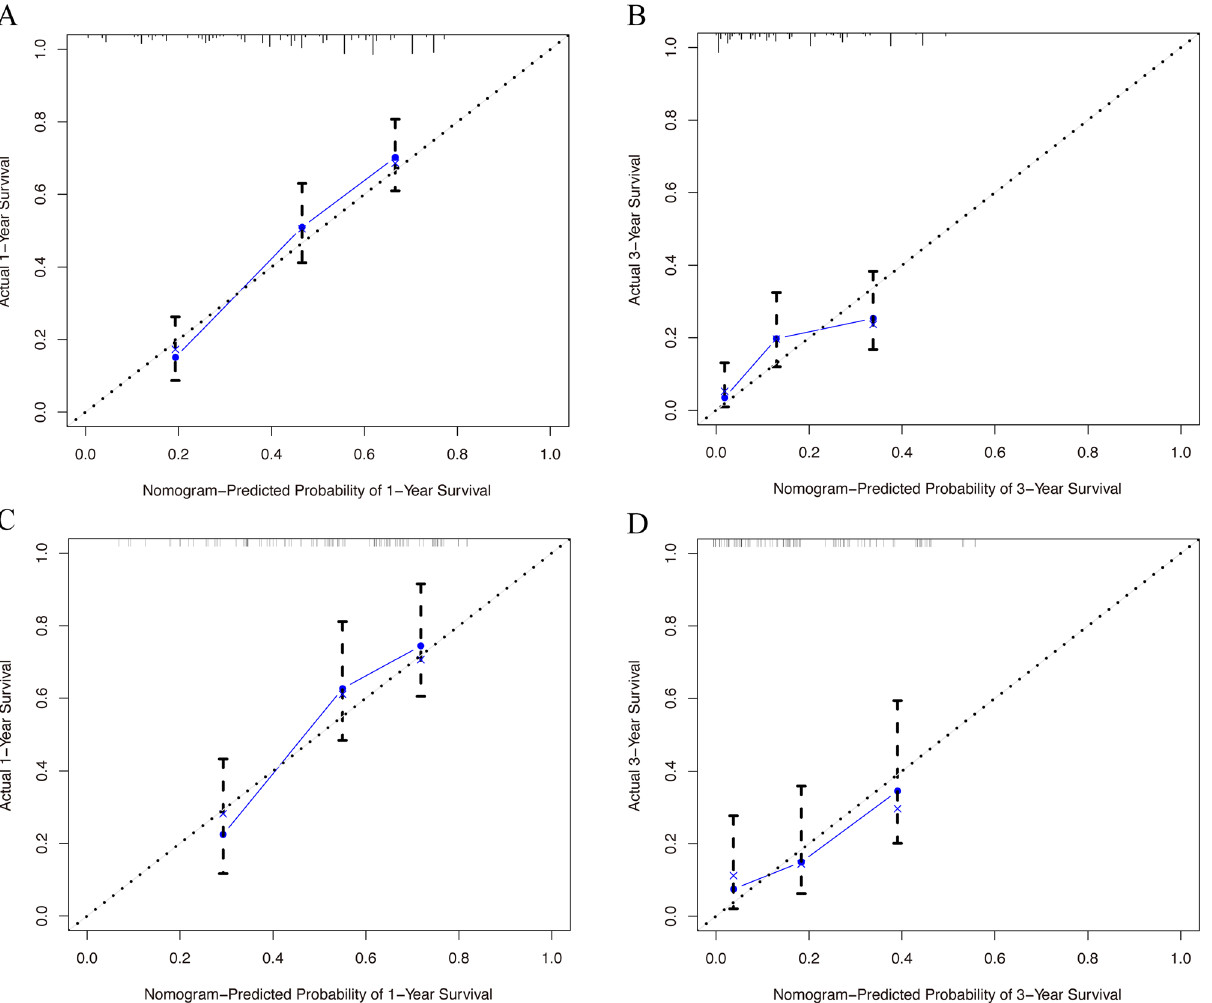
Figure 4. Calibration plot of the nomogram for 1- and 3-year CSS: ( A ) at 1 year in the training set; ( B ) at 3 year in the training set; ( C ) at 1 year in the validation set; ( D ) at 3 year in the validation set. CSS, cancer-specific